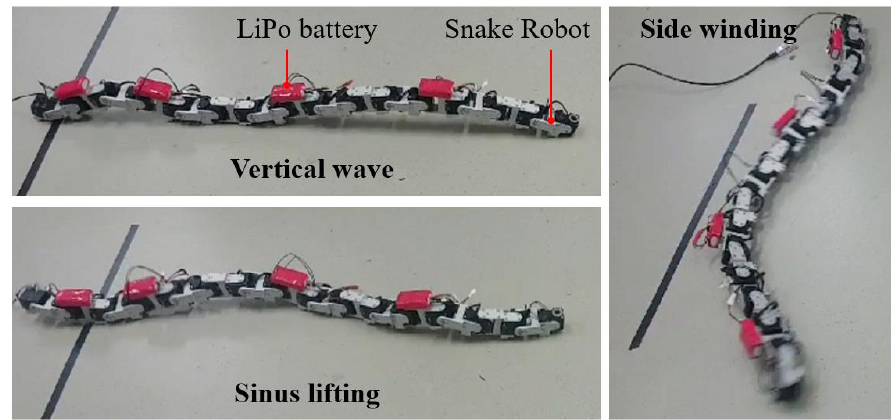
Appl. Sci. 2020 , 10 , x FOR PEER REVIEW Figure 8. The snake robot's gait types on flatland. Figure 8. The snake robot’s gait types on flatland.